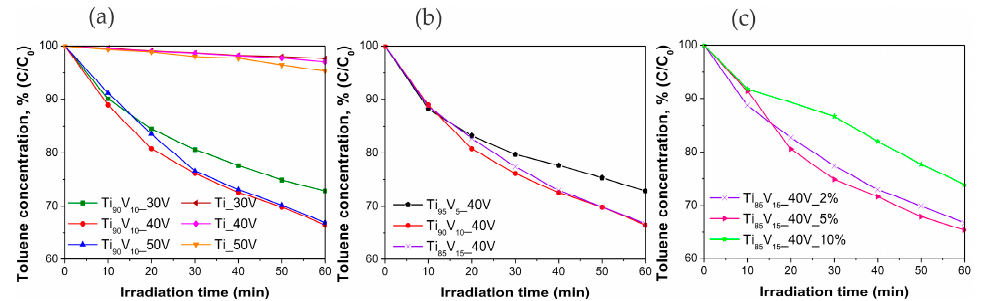
Figure 8. Photoactivity of pristine TiO 2 NTs and V 2 O 5 -TiO 2 NS in gas phase degradation of toluene under Vis-light irradiation ( λ max = 465 nm). Effect of ( a ) applied voltage; ( b ) vanadium content in the alloy; and ( c ) water content in the electrolyte.